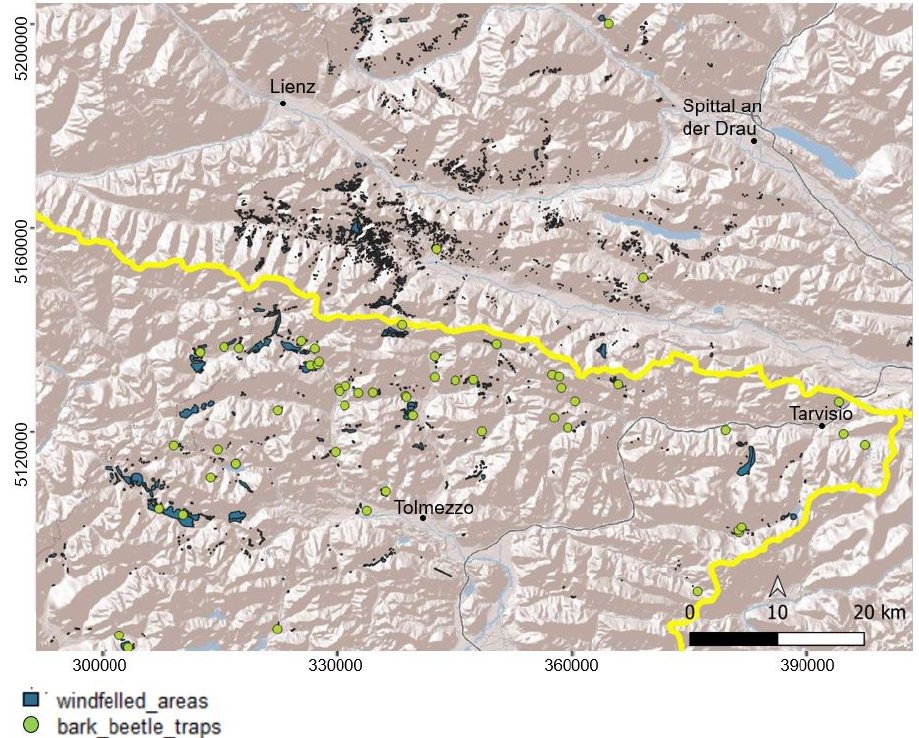
Figure 3. Reference data distribution over the study area showing the location of bark beetle pheromone traps and wind-felled patches (ESRI Shaded Relief base map). Reference system: WGS84-UTM33N.